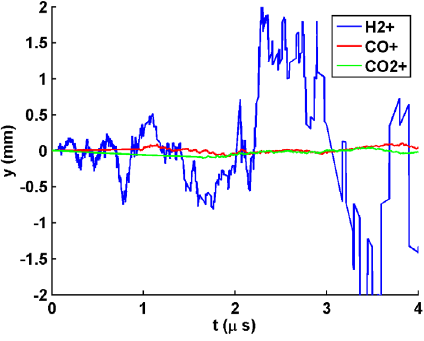
FIG. 20. Oscillation of ion clouds ( y -component) consisting of H þ 2 , CO þ , CO þ 2 ions around the beam potential of a 50 MeV bunch with Gaussian distribution and a repetition rate of 1 MHz.